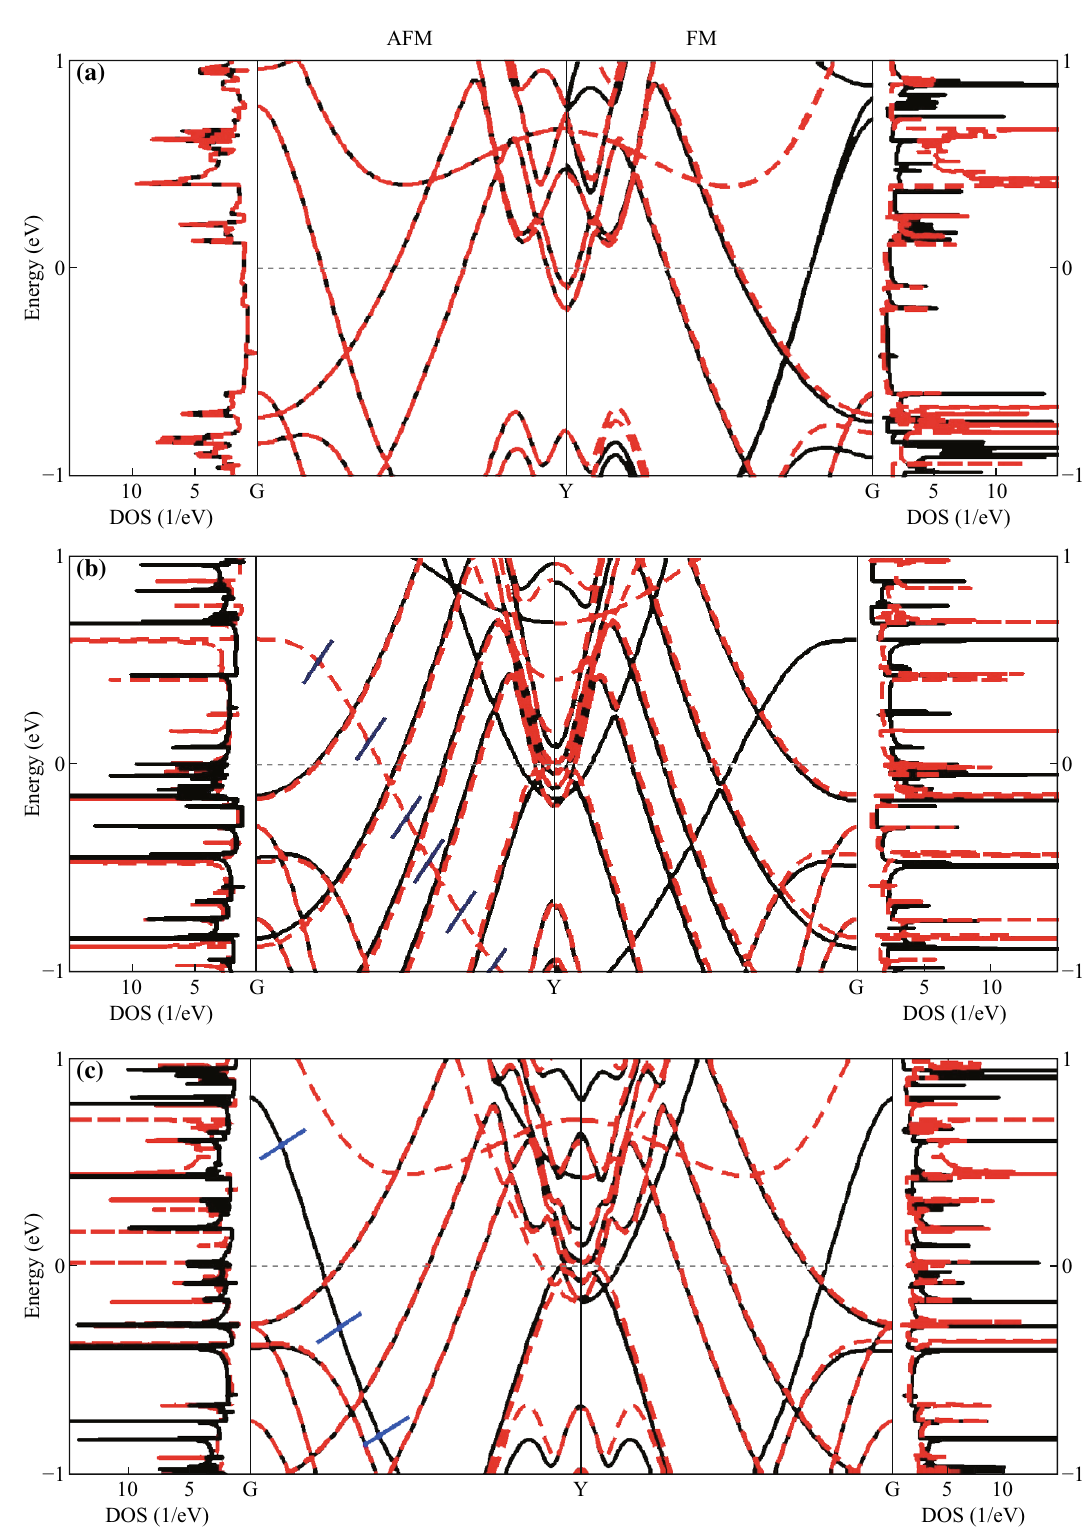
Fig. 10 Spin-dependent band structure of a 22Y51BNR , b 23Y13BNR , and c 24Y31BNR in antiferromagnetic (AFM) and ferromagnetic (FM) configuration. The density of states of each configuration is also drawn. The oblique lines show bands which are arise due to the edge atom with highest magnetic moment. The dashed line is spin-down and the solid line is